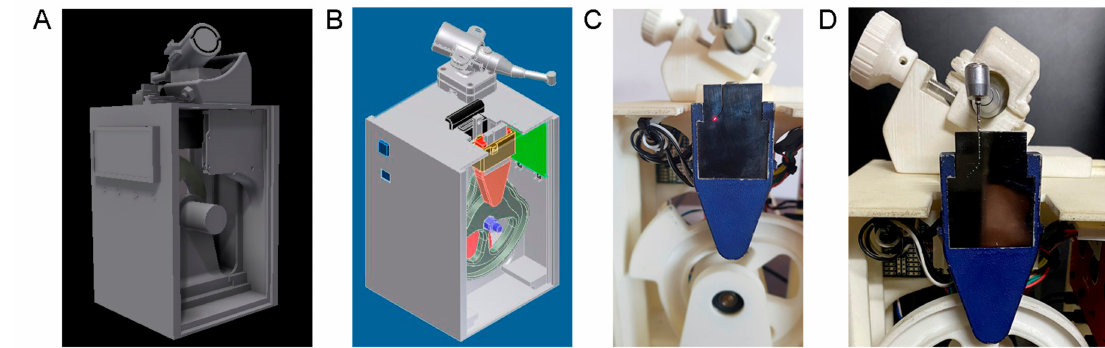
Figure 4. ( A ) Back and ( B ) front surfaces of the 3D design of the dynamic cyclic fatigue hardware device, with the reduction handpiece ( C ) located on the top of the dynamic cyclic fatigue hardware device and the NiTi endodontic rotary file ( D ) inside the artificial root